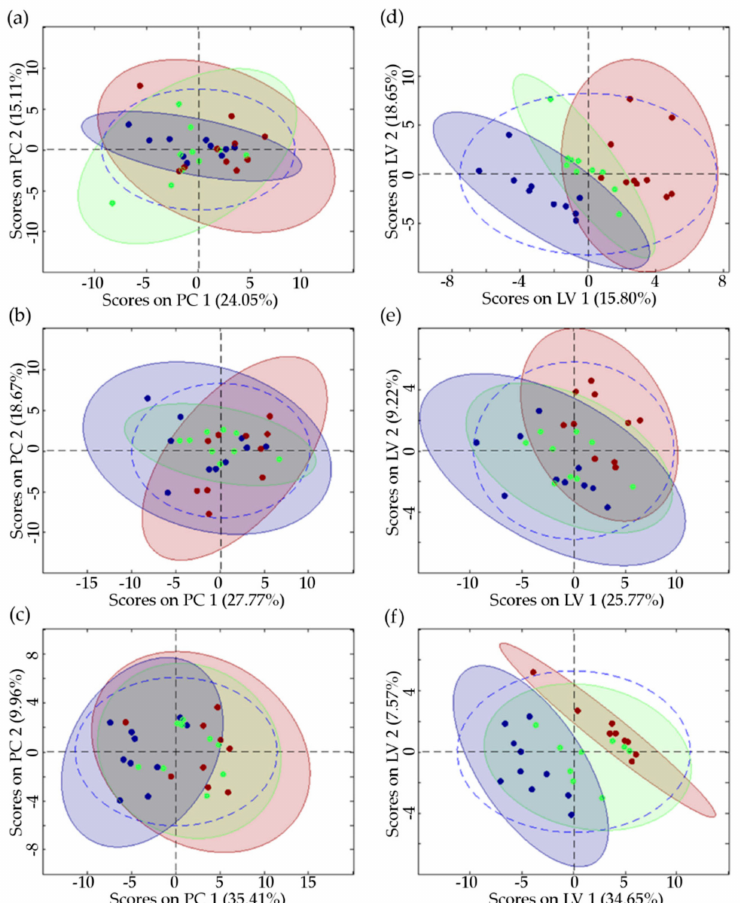
Figure 3. Principal component analysis (PCA; left side) and partial least squares method (PLS; right side) score plots of the aliphatic region (of 1-D PROJECT spectra) of ( a , d ) HEK-293, ( b , e ) A2780, and ( c , f ) A2780cisR cells treated with 0.03 µ M of DiRu-1 (blue) or 0.015 µ M of DiRu-1 (green) or untreated as the control (red). The ellipses show 95% confidence interval. The corresponding parameters are shown in Table